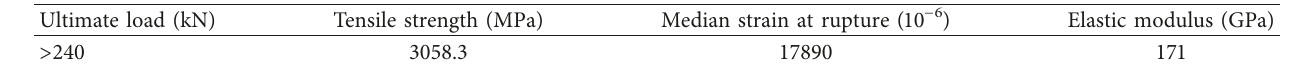
Table 5: Physical properties of 10mm FRP